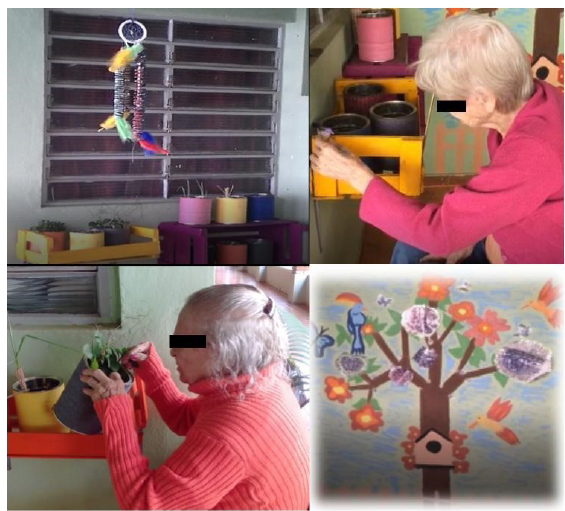
Figure 1. The sensory garden had aromatic plants, wind bell, and textures in painting on the wall.